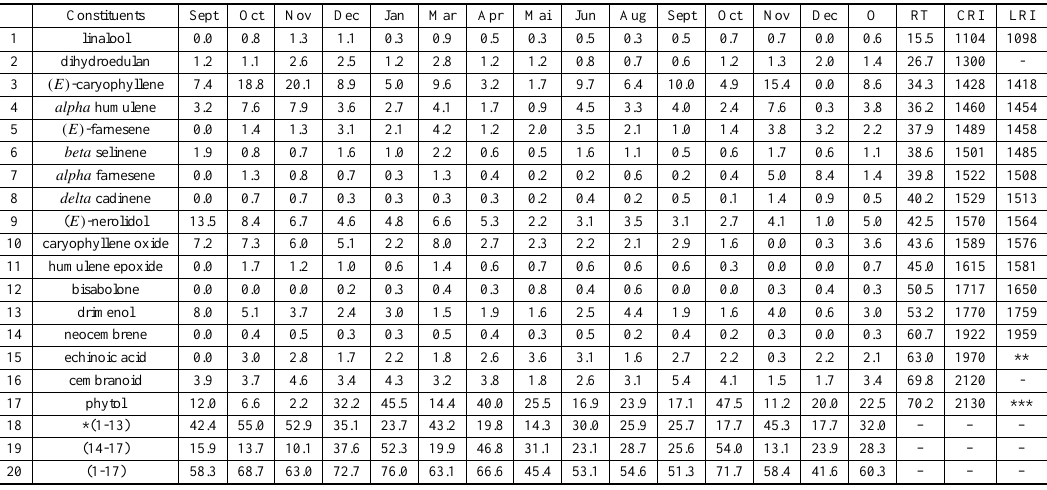
TABLEII Identified constituents of E. grandiflorus essential oils from SL-population with their percentage monthly recorded in GC-analysis for the period September 1998 to December 1999, together their mean percentage of oil (O), the mean retention time (RT) and the mean calculated retention indices (CRI) as well as the literature RI